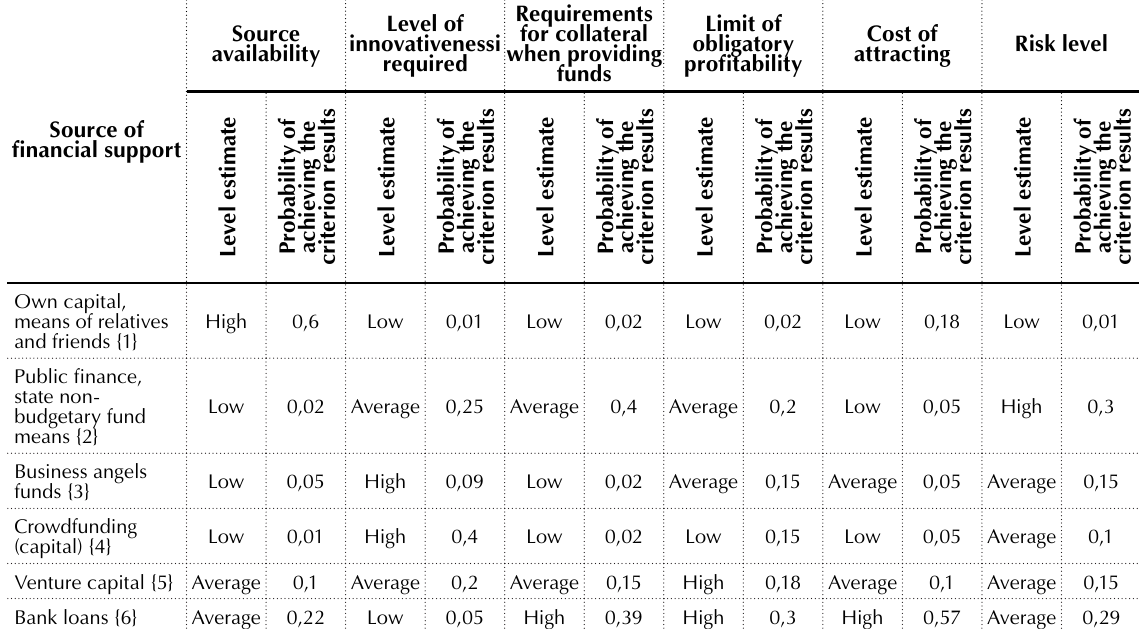
Table 4. Data for decision tree